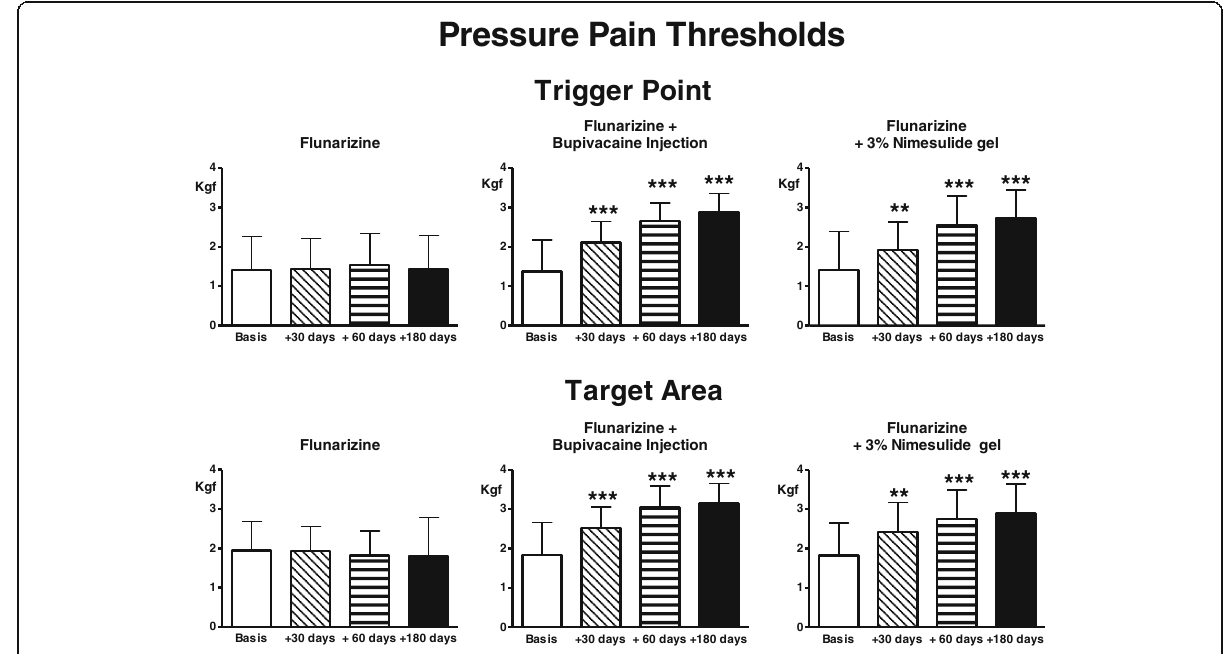
Fig. 4 Pain thresholds to pressure stimulation in the trigger point and the target area. Legend as for Fig. 1